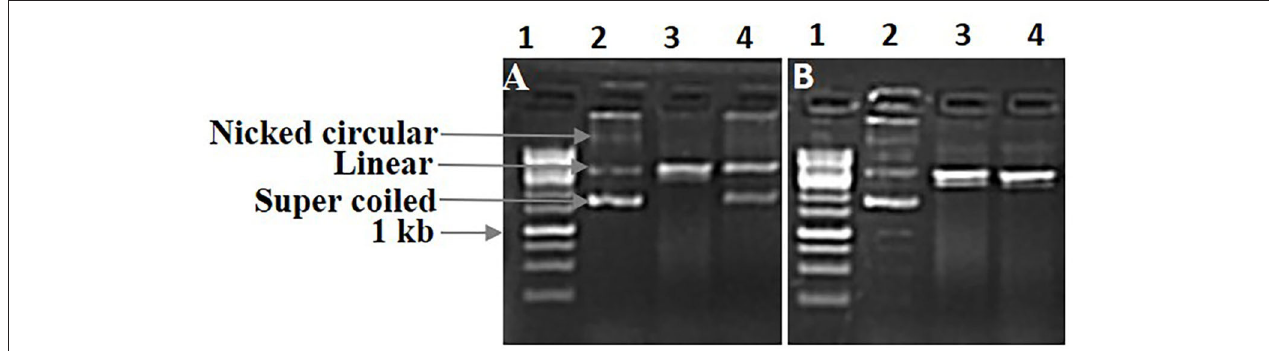
FIGURE 3 | DNA damage protecting activity of L. camara FE and LE against hydroxyl radical induced DNA damage of pGEM-T plasmid. Lane 1: Ladder 1kb; Lane 2: pGEM-T plasmid DNA; Lane 3: DNA + Fenton’s reagent; Lane 4: DNA + Fenton’s reagent + extract (5 mg/ml). (A) FE and (B) LE.